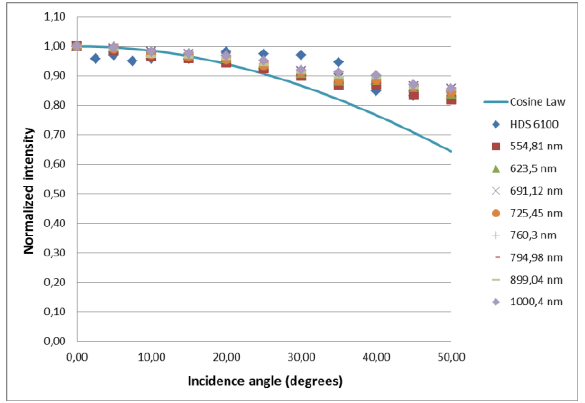
Figure 4. Black-painted Kivenlahti beach sand (>500 µm grain size) scanned with hyperspecral Lidar, compared with the same sand sample scanned with the Leica HDS6100 from the experiment described in section 2.3. The wavelength channels are denoted in the legend. Intensity is normalized to 1 at 0 ⁰ .